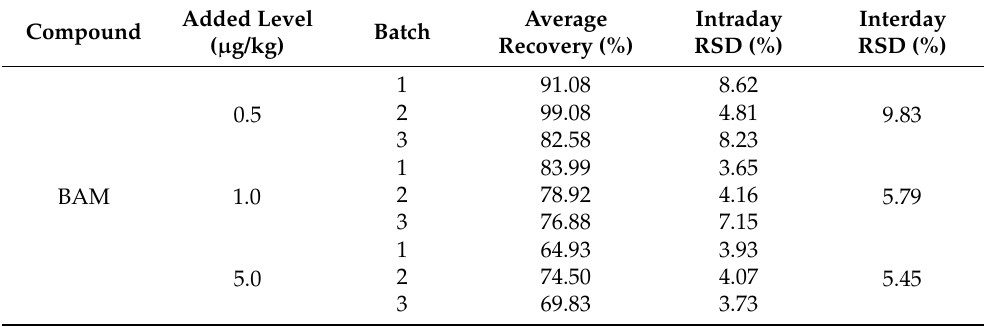
Table A3. Average recovery, intraday precision, and interday precision of the sixteen β -agonists in lamb samples (n =